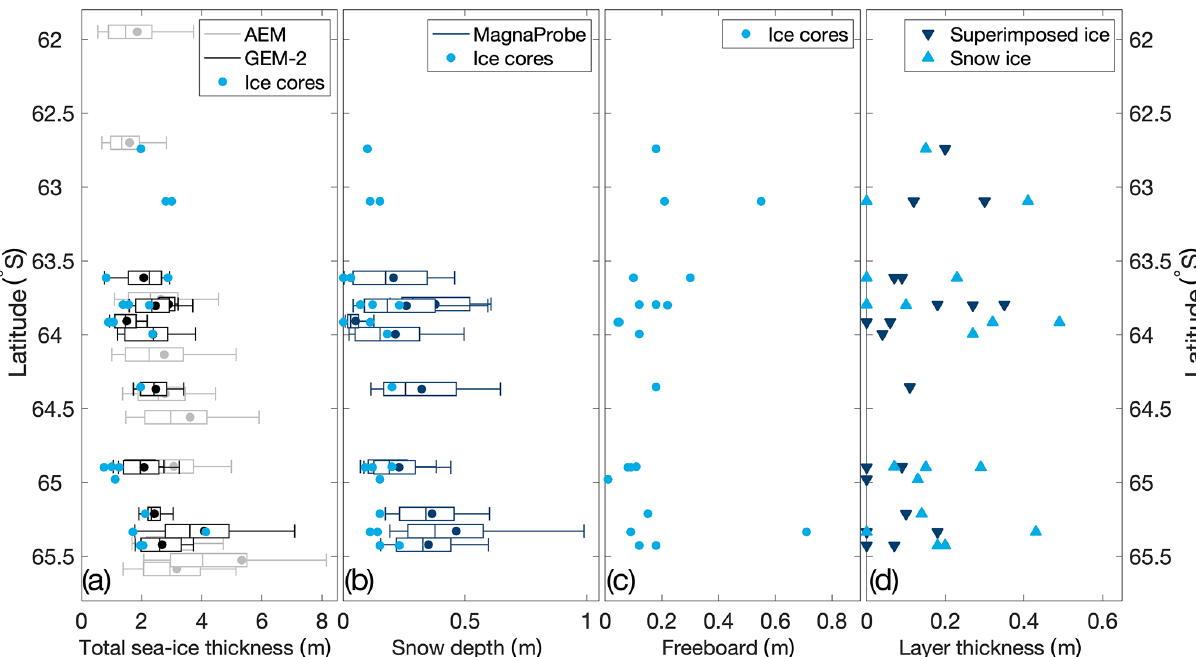
Figure 2. Ice and snow properties versus latitude: (a) total sea ice thickness (SIT, sea ice thickness plus snow depth) derived from airborne electromagnetic induction sounding (AEM, grey), ground-based EM sounding (GEM-2, black), and ice cores (light blue); (b) snow depth measured with the Magna Probe along GEM transects (dark blue) and measured at the ice-coring sites (light blue); (c) freeboard measured at the ice-coring sites (light blue); and (d) thicknesses of superimposed ice (dark blue triangles) and snow ice (light blue triangles) from all ice cores. Boxes are the first and third quartiles and whiskers the 10th and 90th percentiles. Circles indicate means and vertical lines in the boxes